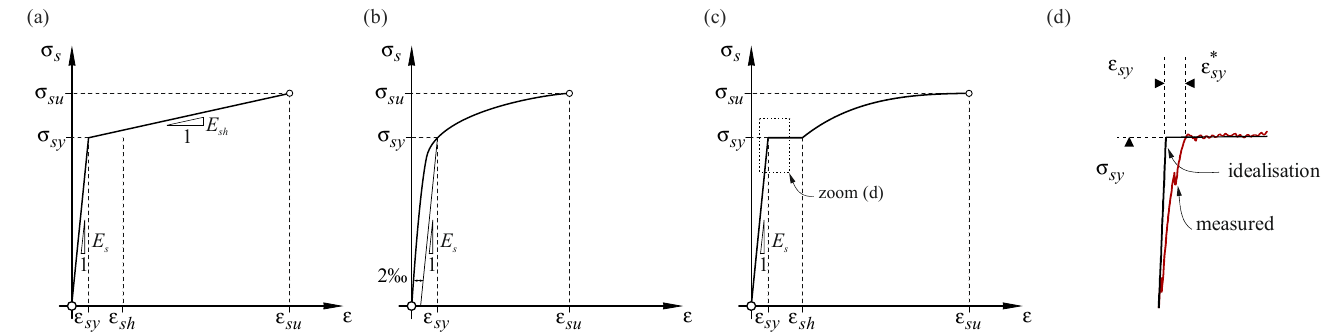
Figure 6. Stress–strain characteristics of reinforcing steel in uniaxial tension: ( a ) bilinear idealisation; ( b ) idealisation for cold-worked (CW) steel; ( c ) idealisation for quenched, self-tempered (QST) steel and ( d ) comparison of the idealisation for QST to author’s test data—the visualisation is limited to the marked area in ( c ).